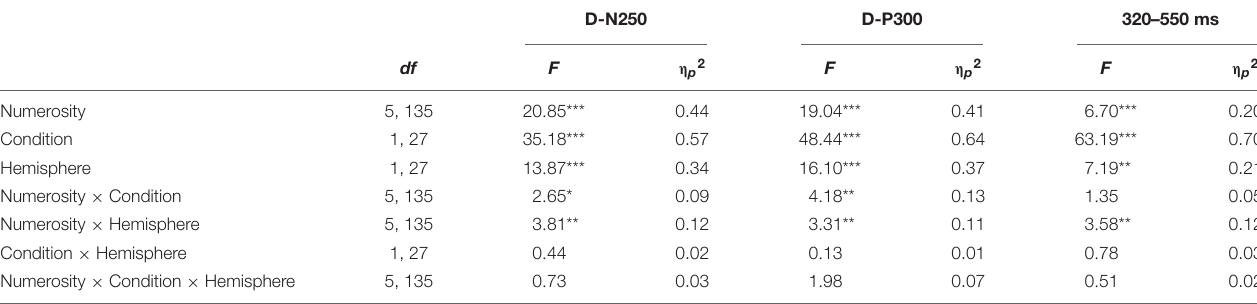
TABLE 2 | Mean amplitude three-way repeated measures ANOVA results for numerosity, condition, and hemisphere effects on each time